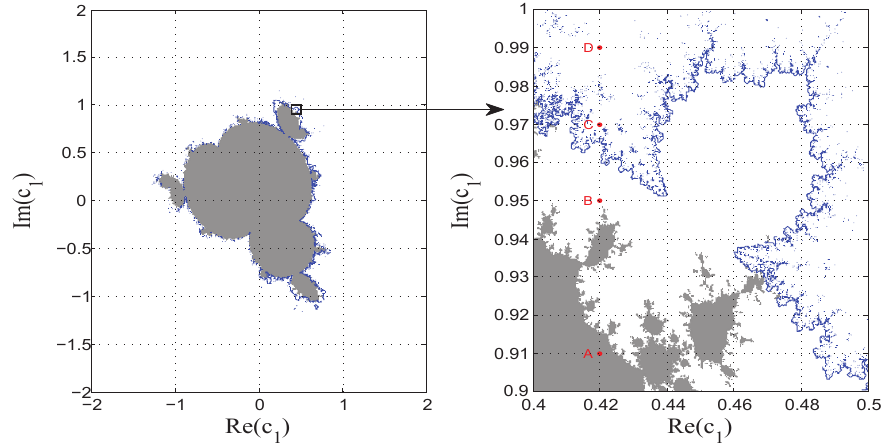
Figure 4. Planar M ( P ) with c 2 = 0 + 0.3 i